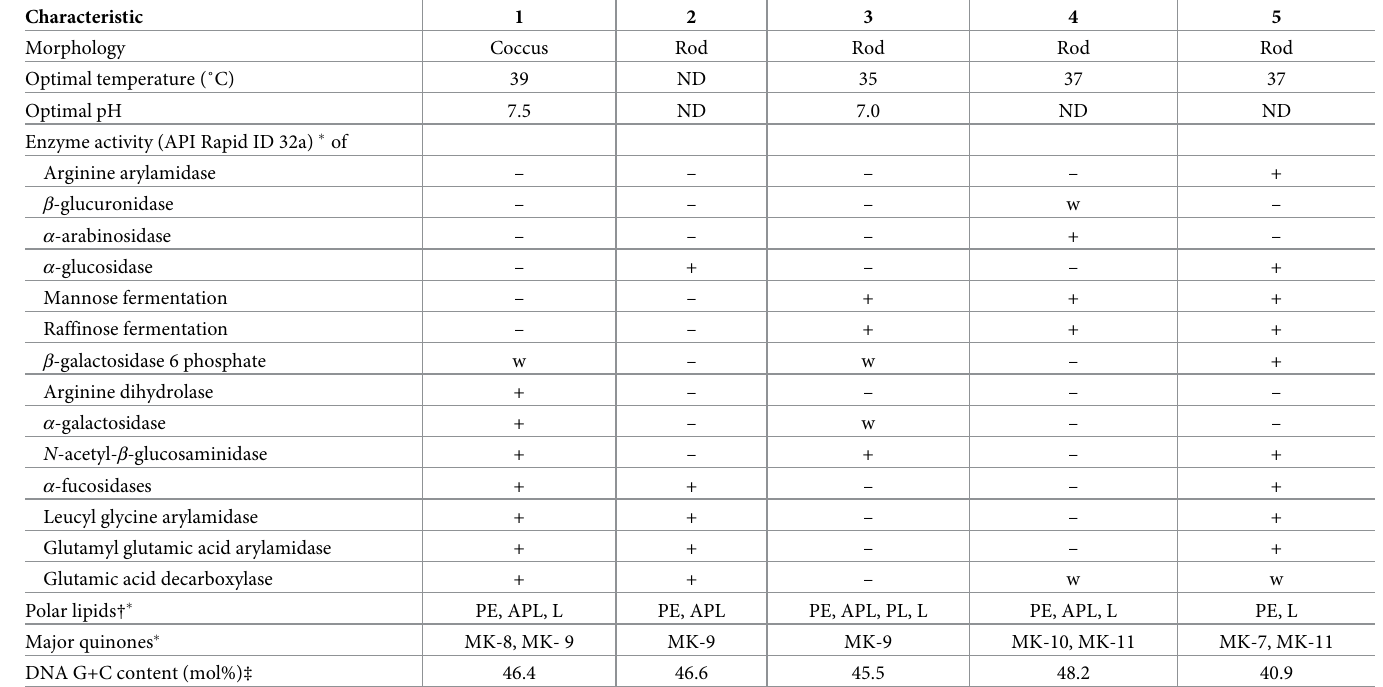
Table 1. Comparison of phenotype characteristics of strain E39 T and closely related